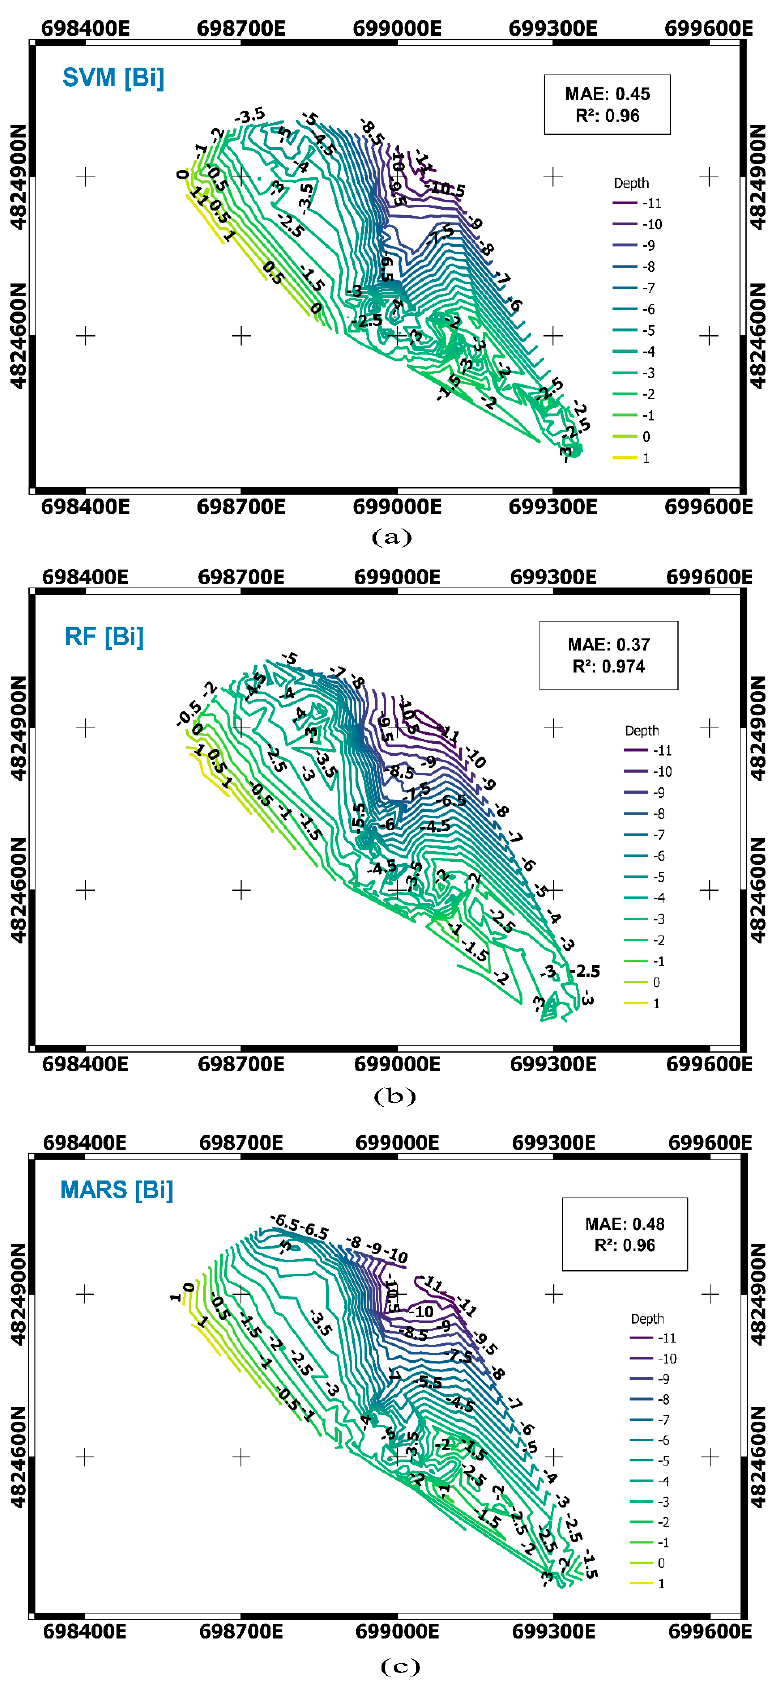
Figure 10. Comparison of water depth maps of Luarca obtained using different algorithms ( a ) SVM, ( b ) RF and ( c ) MARS, using ratios bands as input variables. The color indicates the depth in meters.